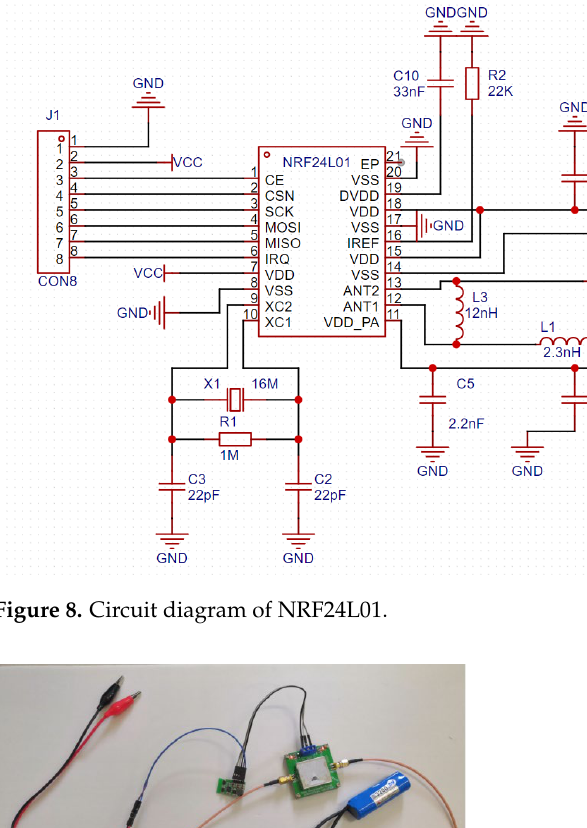
Figure 10. Circuit diagram of 2.8 V–9 V to ±5 V.